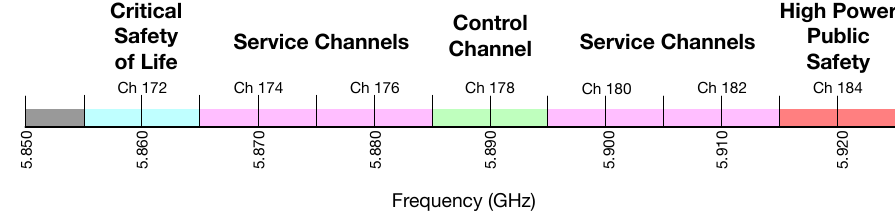
Figure 1. Dedicated short-range communication (DSRC) spectrum.